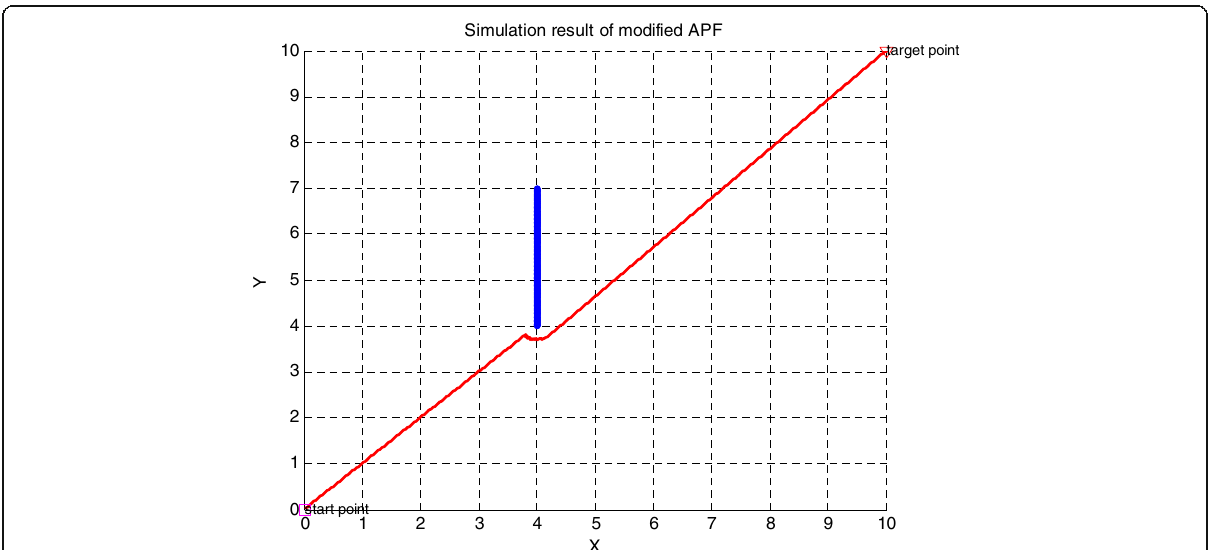
Fig. 23 The result of the straight line obstacle simulation in the modified artificial potential field algorithm